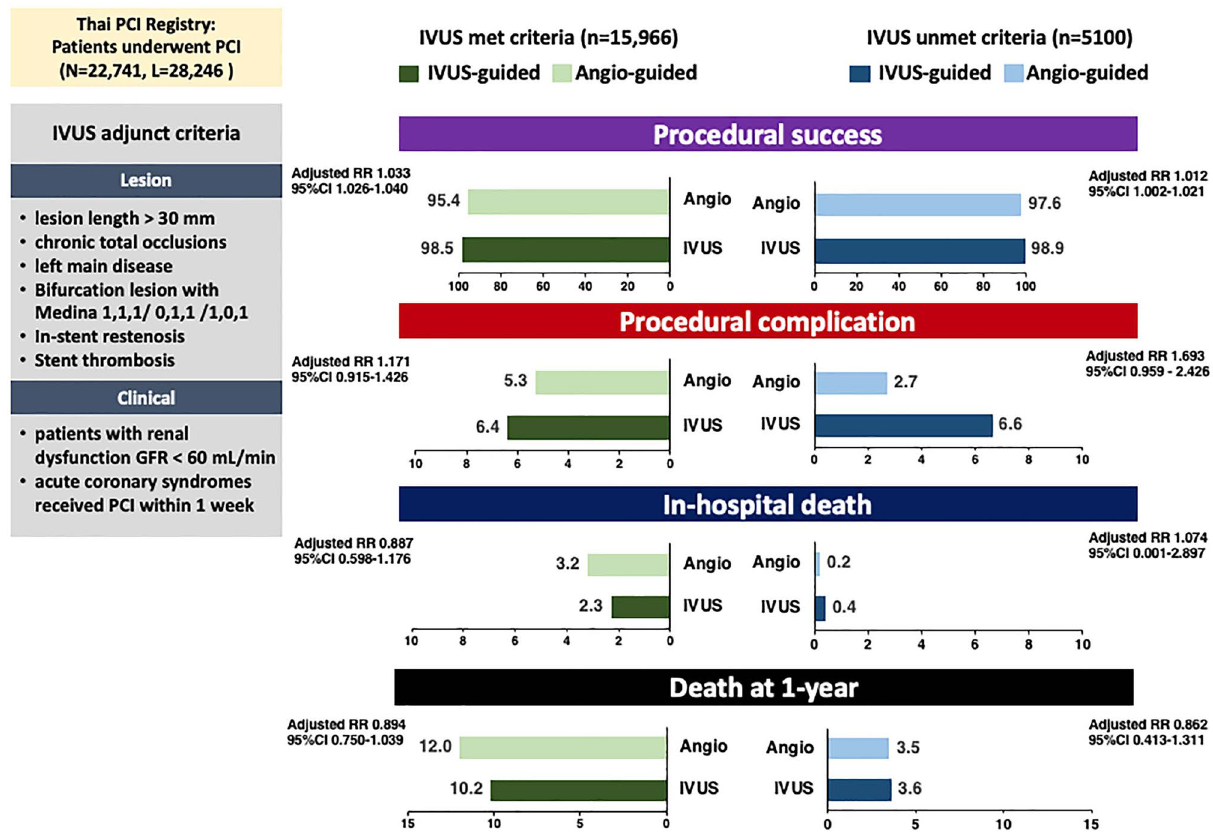
Figure 4. Graphic abstract. Abbreviation: CI, confidence interval; GFR, glomerular filtration rate; IVUS, intravascular ultrasound; PCI, percutaneous coronary intervention; RR, relative